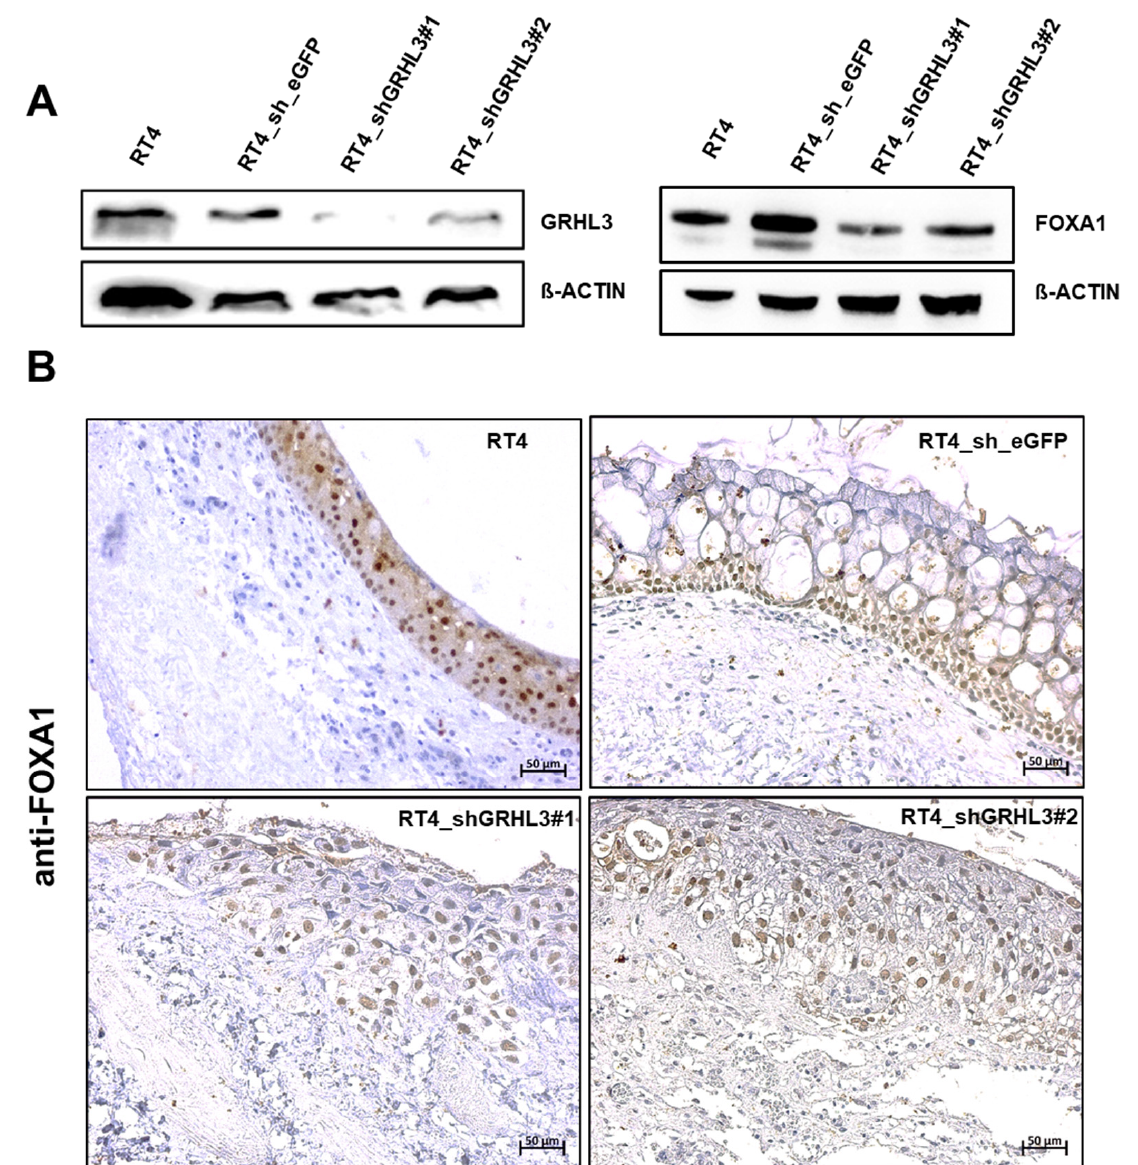
Figure 8. GRHL3 downregulation promotes a more invasive phenotype of RT4 cells in porcine organ culture. ( A ) Downregulation of GRHL3 protein by shRNAs in RT4 cell lines is shown by Western blot. Two shRNA constructs targeting GRHL3 and one control shRNA (sh_eGFP) were used to infect RT4 cells. Both shRNA constructs downregulated GRHL3 expression. FOXA1 expression is slightly reduced in RT4 cells after knockdown of GRHL3. ( B ) Immunolabeling of FOXA1 in RT4 cells grown in organ culture shows that FOXA1 expression can be detected in parental RT4 and in GRHL3 knockdown RT4 cells. Morphologically, parental and shRNA control-transduced RT4 cells formed a multi-layered epithelial lining, while knockdown of GRHL3 by both shRNAs showed more loose cell clusters with beginning stromal invasion (lower panel). Vacuoles in shRNA control-transduced RT4 cells may be indicative of cell stress. Scale bar, 50 µm.